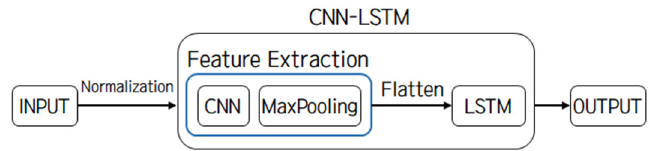
Figure 3. CNN-LSTM configuration.